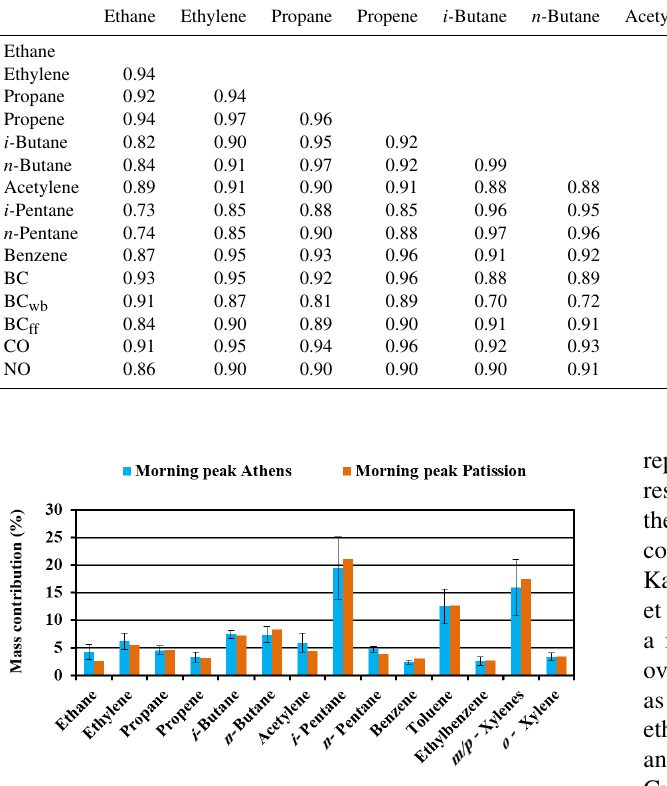
Figure 9. % Mass contribution of the measured NMHCs during the morning peak (07:00–10:00LT), median values in Thissio and mean values at Patission monitoring